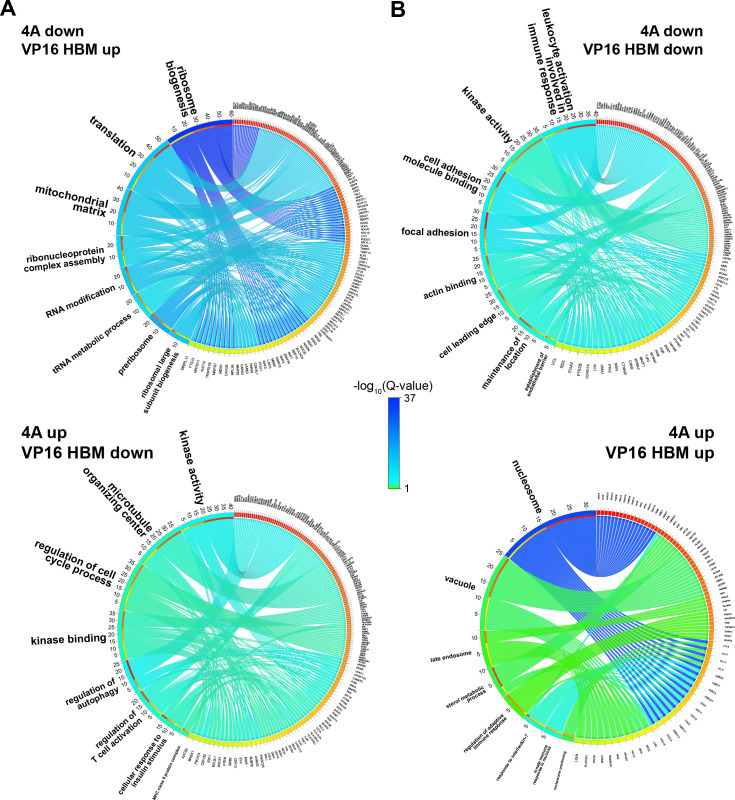
Gene ontology (GO) enrichment analysis of correlative and anti-correlative effects on gene expression.(A and B) Categories from the top eight families in GO enrichment analysis of the anti-correlated (A) and correlated (B) gene clusters shown in Figure 3D, for transcripts that were decreased (top) or increased (bottom) with the 4A mutant. The Q-value of categories is represented by the ribbon color, which is scaled across these figures. Categories are ranked by the number of matched genes, and genes are ranked by the number of categories into which they fall.